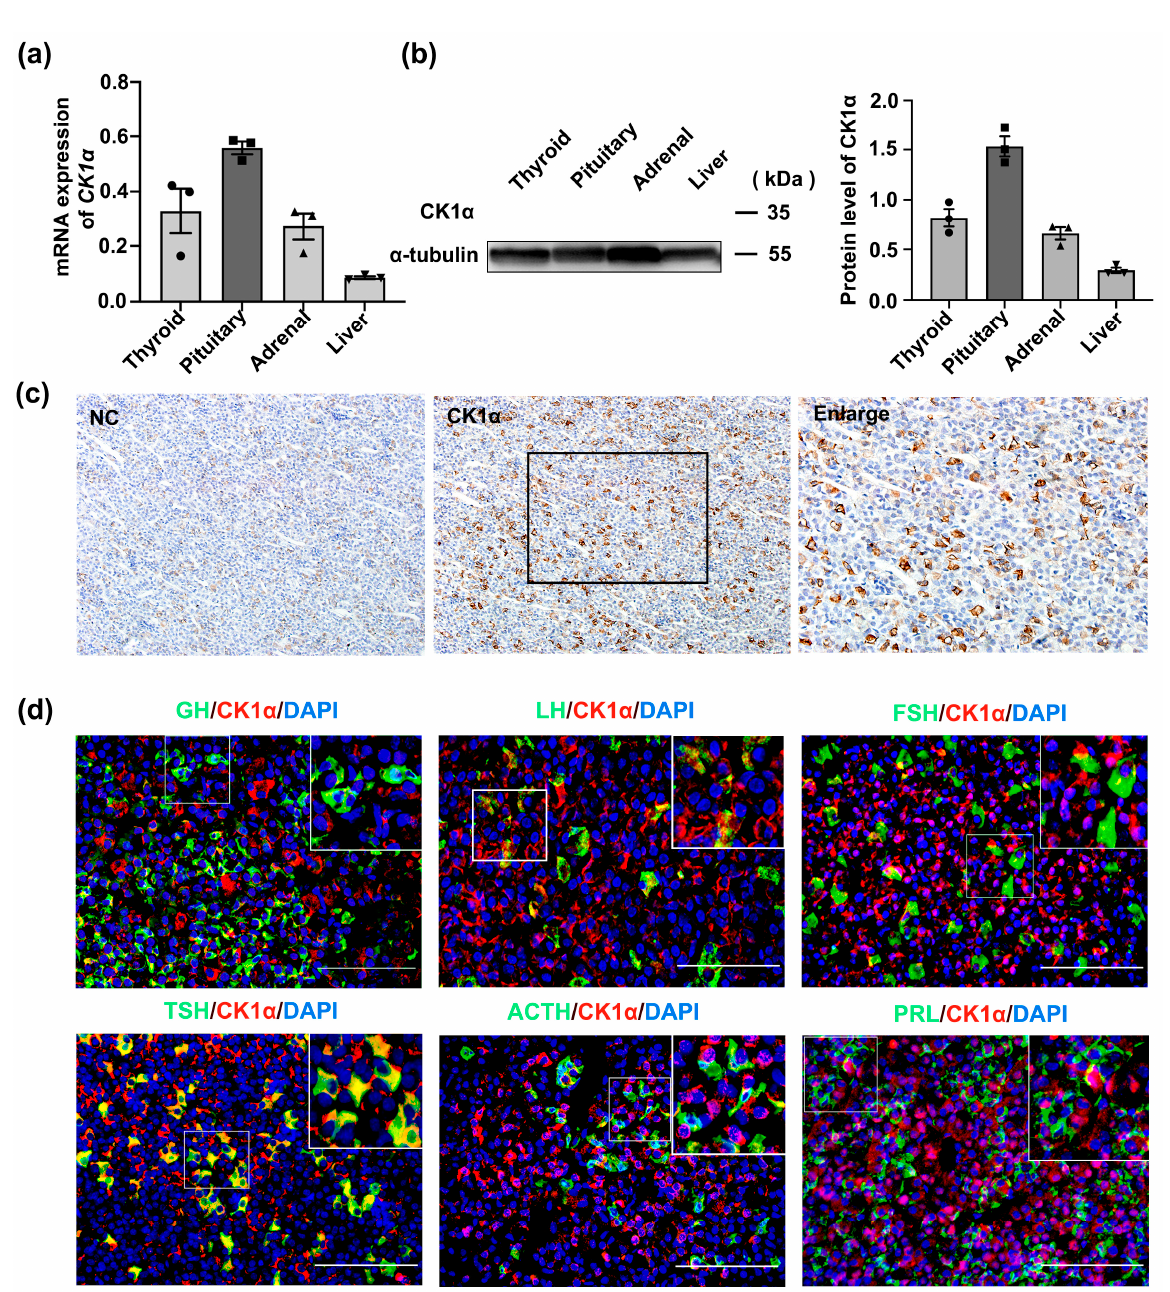
Figure 1. CK1 α is expressed in murine pituitary thyrotropes. ( a ) The expression of CK1 α in different mouse tissues was detected using real-time PCR (RT-PCR) and normalized to Gapdh expression. Data are presented as means ± standard error of the mean of three stand-alone experiments. ( b ) CK1 α protein expression in different mouse tissues was analyzed using Western blotting and normalized to α -tubulin expression; n = 3. ( c ) The expression of CK1 α in pituitary tissue was detected using immunohistochemistry. Scale bar = 100 µ m. ( d ) Detection of CK1 α expression in different pituitary cell types using immunofluorescence chemistry. Scale bar = 100 µ m. Each experiment was independently repeated three times.